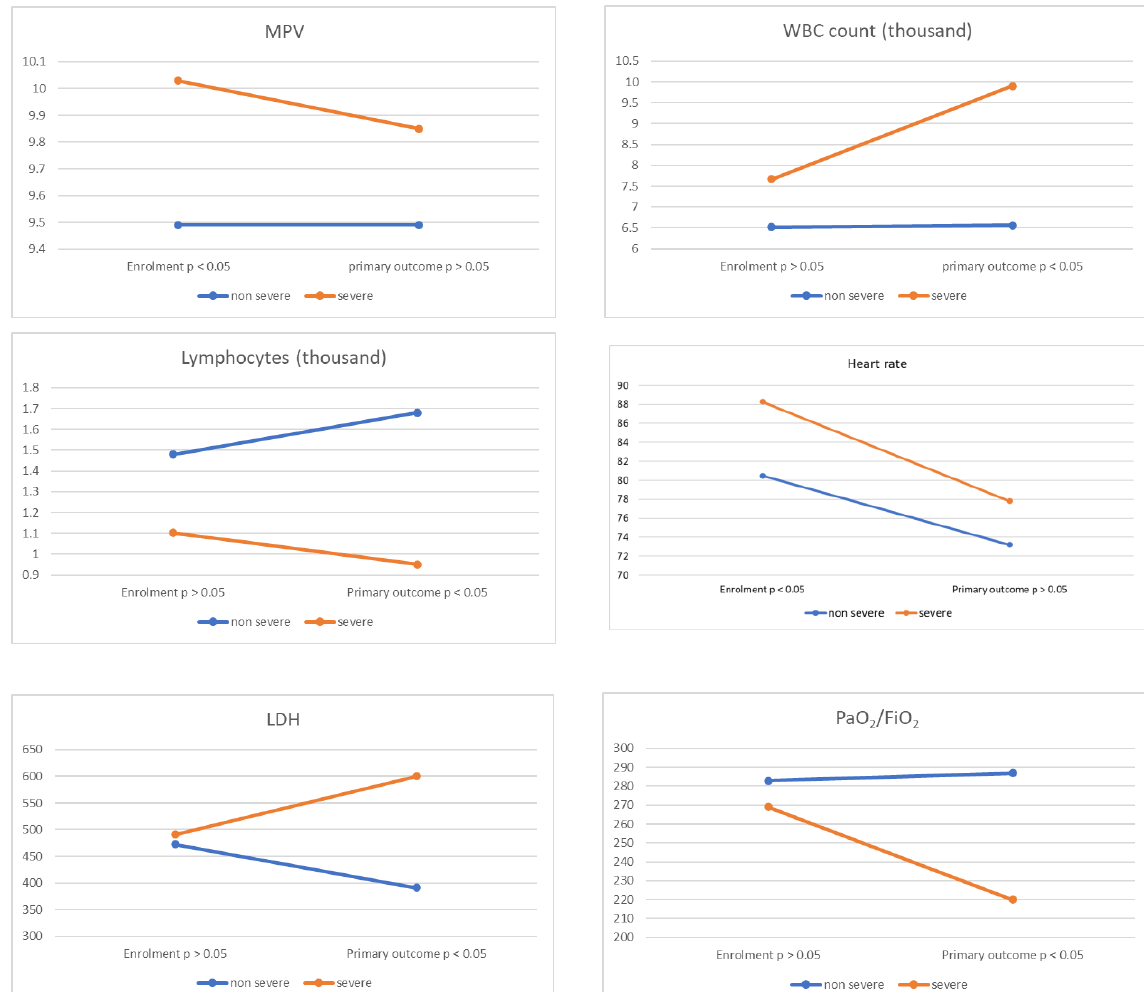
Figure 2. Evolution of laboratory tests from enrolment to primary outcome. (Mann-Whitney-W test, student’s test).